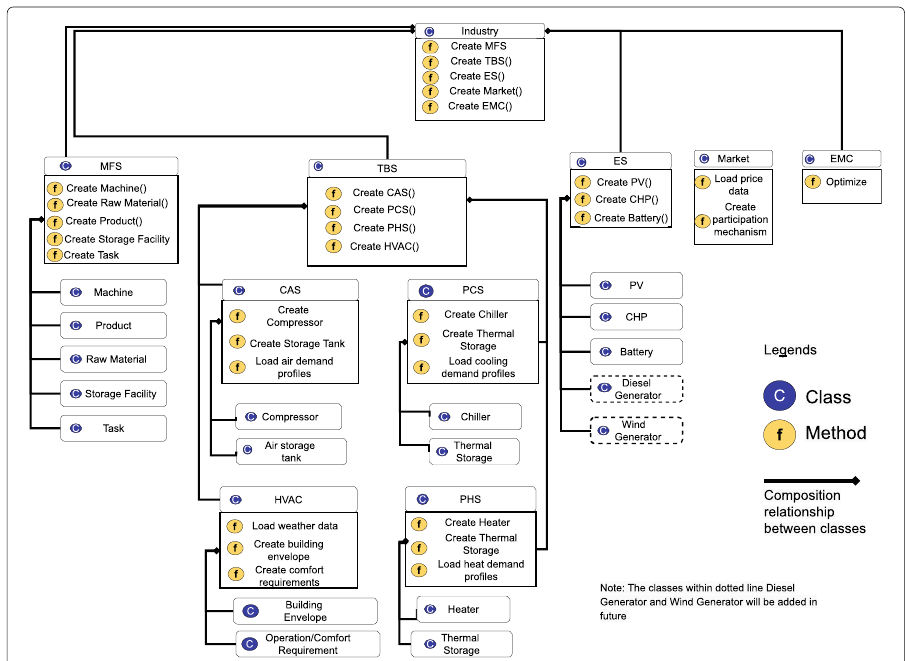
Fig. 3 Modeling diagram of generic industrial enterprise model library - representation of modules and sub-modules in objected oriented